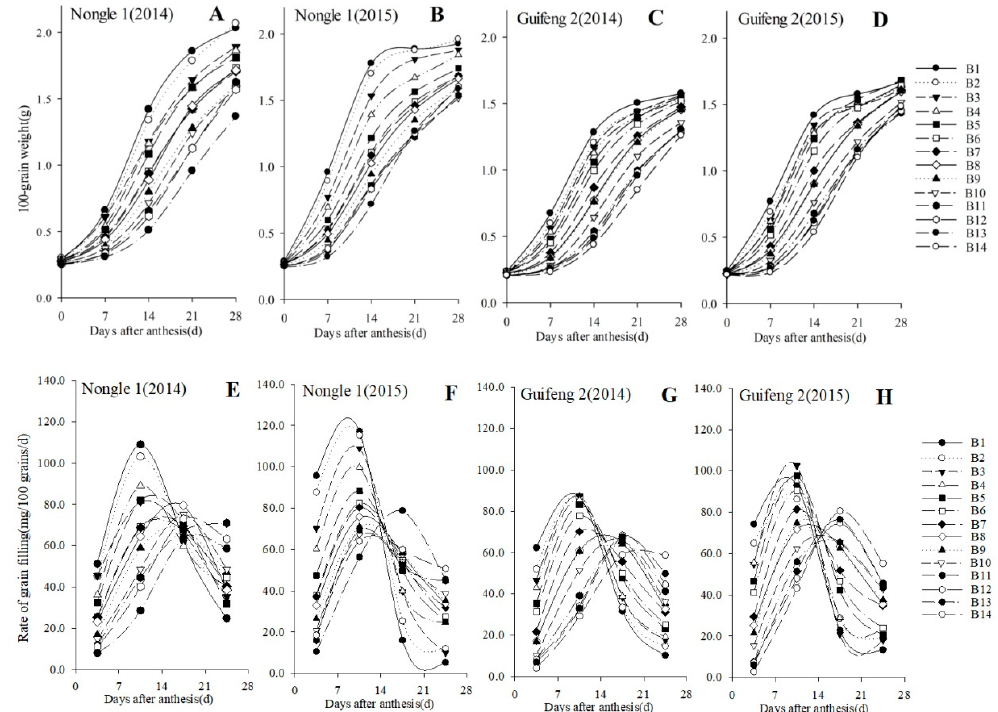
Figure 3. Dynamics of dry-matter accumulation and grain growth rate of primary-branch grains at different positions for two rice cultivars in 2014 and 2015 at different growth stages. ( A , B ) dry-matter accumulation for Nongle 1, ( C , D ) dry-matter accumulation for Guifeng 2, ( E , F ) grain growth rate for Nongle 1, ( G , H ) grain growth rate for Guifeng 2. Data are the mean across three replications. 0, 7, 14, 21 and 28 indicate 0 days, 7 days, 14 days, 21 days and 28 days after anthesis. B1 to B14 represent the grains from the top 1st primary branch to the basal 14th primary branch on rice panicles for Nongle 1 and Guifeng 2.